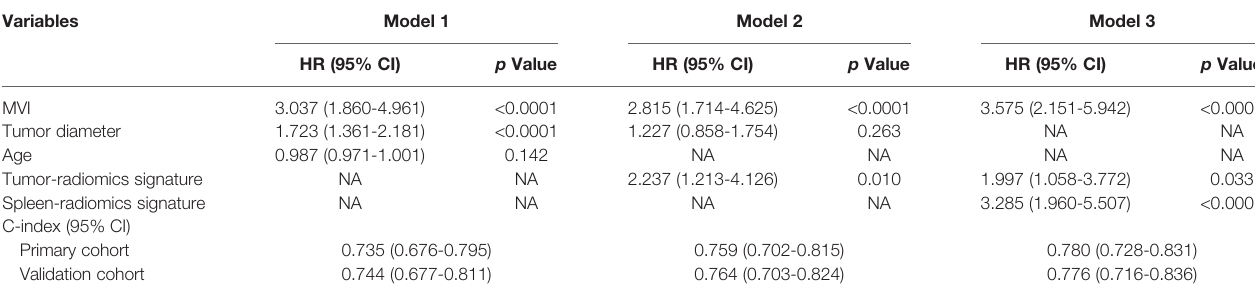
TABLE 2 | Multivariate Cox regression analysis of early recurrence of HCC in the primary